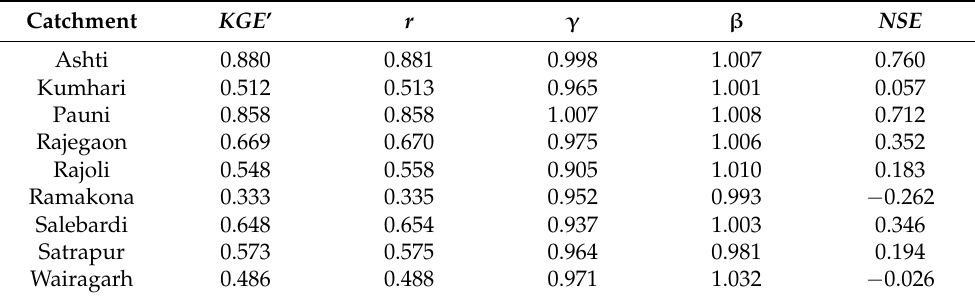
Table 3. Performance metrics (lumped sub-catchment